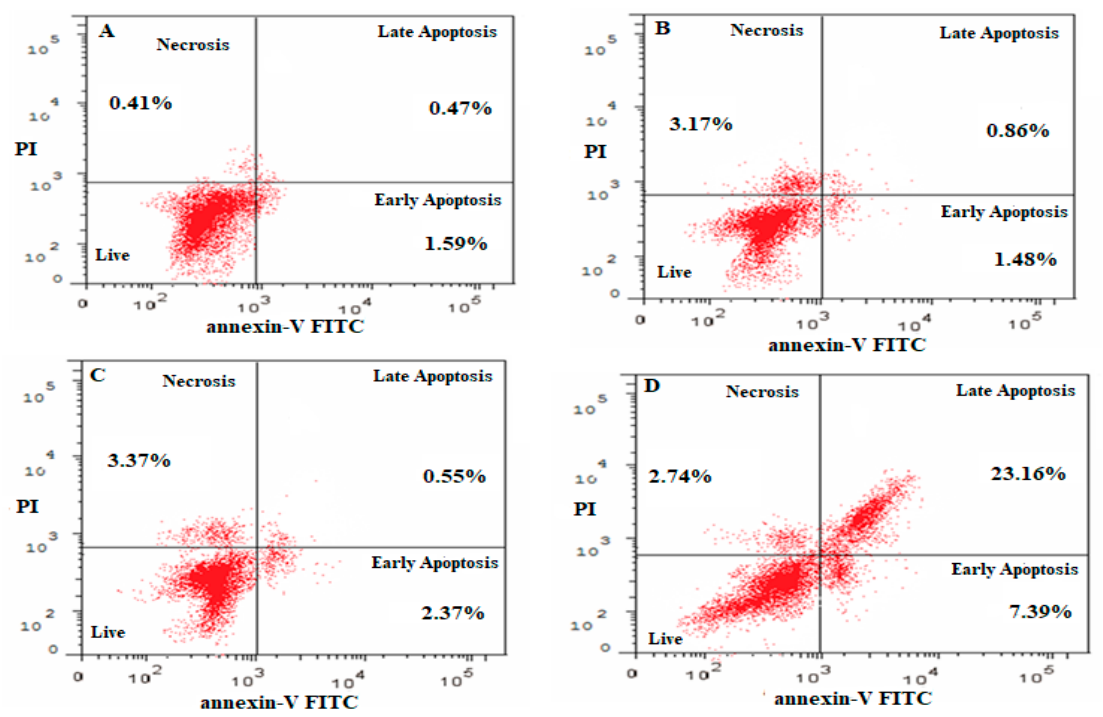
Figure 11. Flow cytometry results using the Annexin V and PI assay showing the distribution of cells in untreated and treated A549 cells: ( A ) control; ( B ) blank NE; ( C ) NAR; ( D ) NAR-NE.